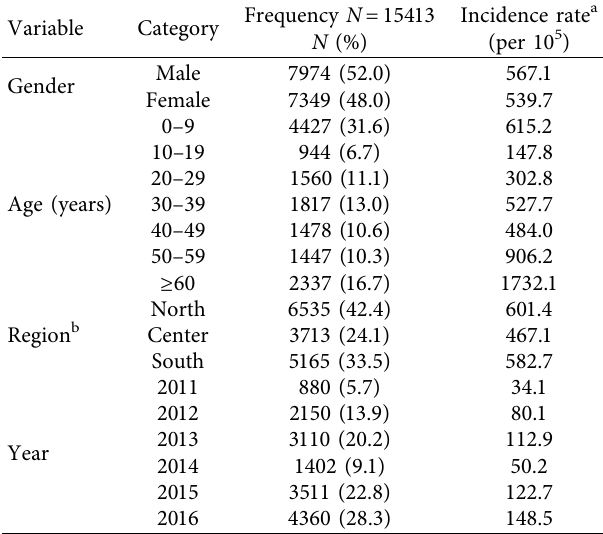
a IR: incidence rate (hospitalized patients per 10 5 population).